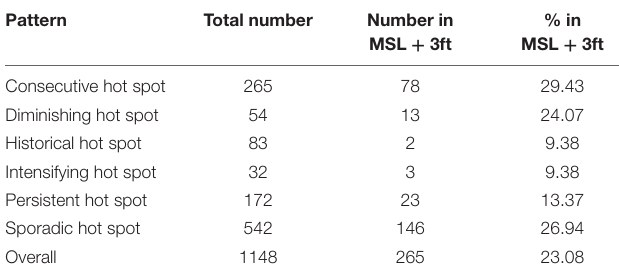
TABLE 2 | Hot spots potentially related to high groundwater